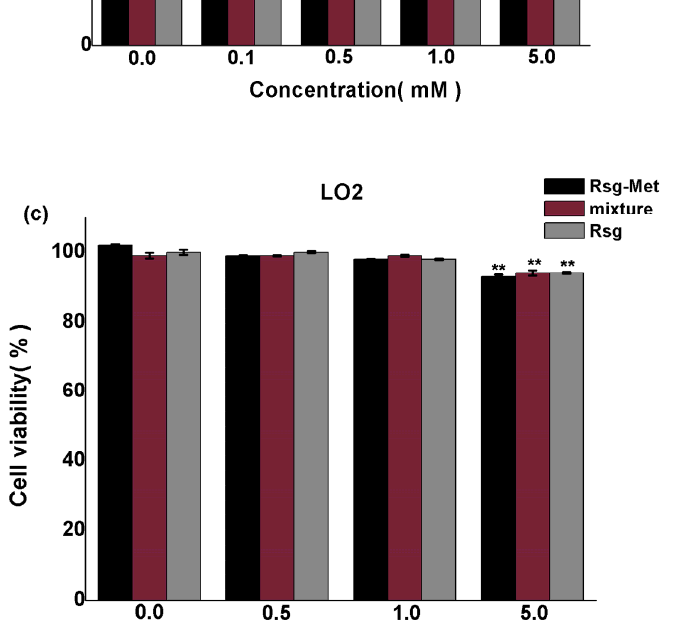
Figure 7. Detection of drug toxicity to ( a ) HepG2, ( b ) SK-hep1, and ( c ) LO2 cells by MTT assay treated with Rsg-Met, the mixture of Rsg and Met at the molar ratio of 1:1 and Rsg (* P < 0.05 and ** P < 0.01 versus the control group).